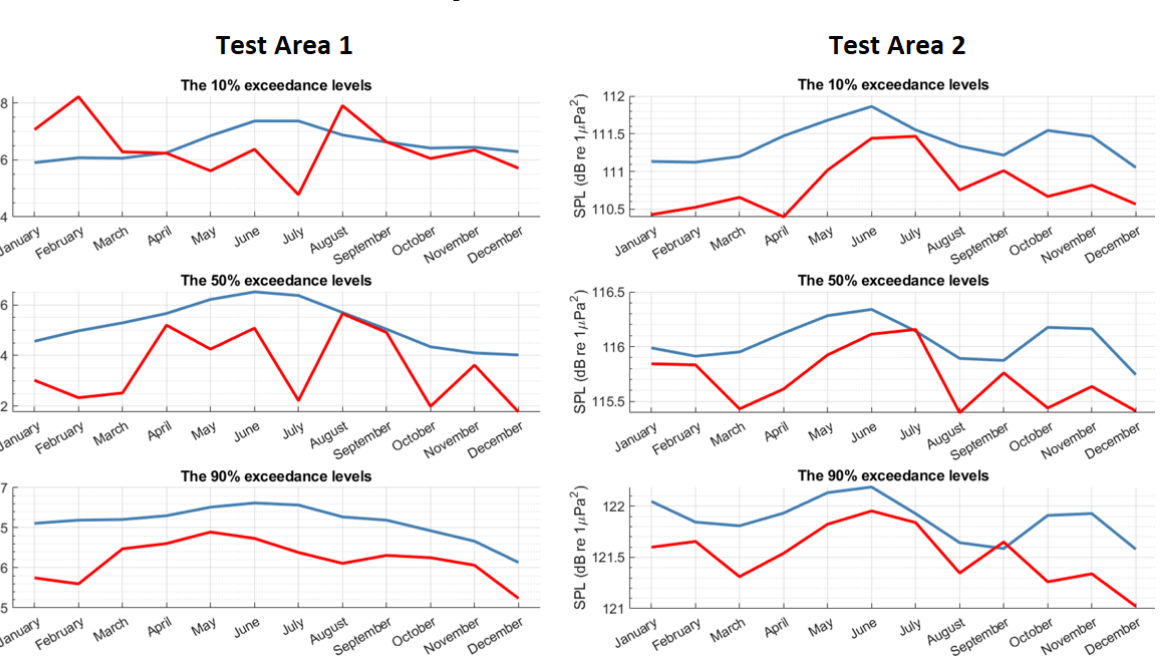
Figure 14. Comparisons for the spatial exceedance levels for 100 Hz to 10 kHz decidecade frequency bands in the test areas. The blue curve is the 2017–2019 average for each month. The red curve is the spatial exceedance levels of